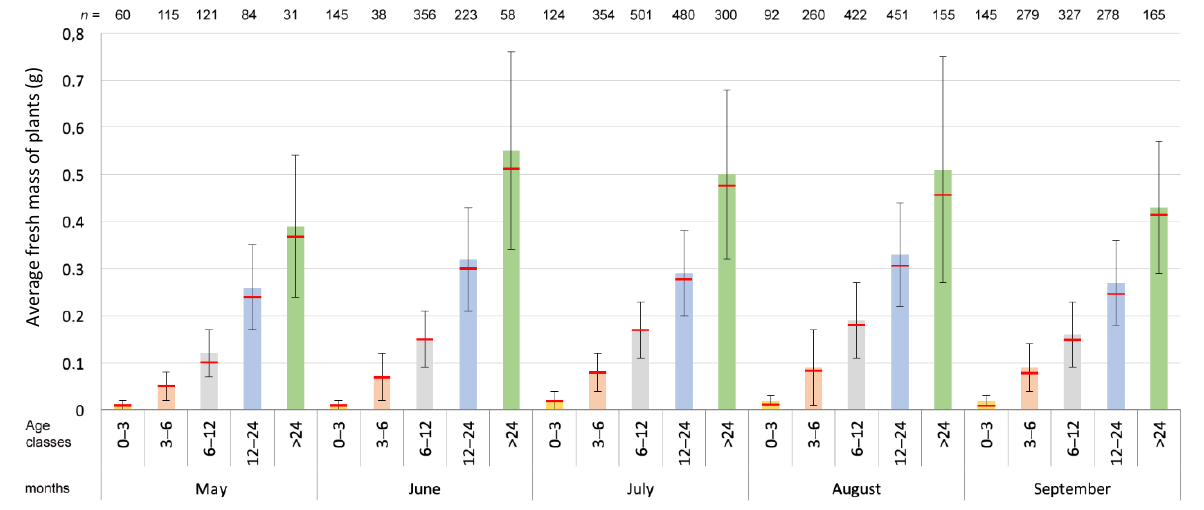
Figure A4. Fresh biomass of individual Drosera rotundifolia plants (flowering and non-flowering) collected between May/June and September in 2013 and 2014 on the Sphagnum palustre and Sphagnum papillosum fields, ordered by age class (0–3, 3–6, 6–12, 12–24, >24 months). Vertical bars show the means, the red lines medians and the whiskers standard deviation. Number of replicates ( n ) is written above each bar.